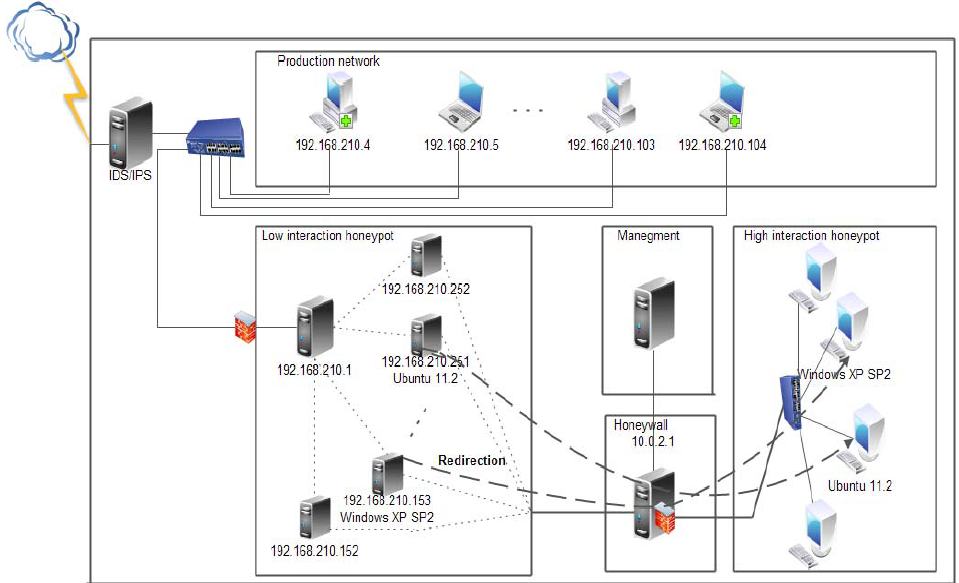
Fig 4 The proposed system deployment architecture